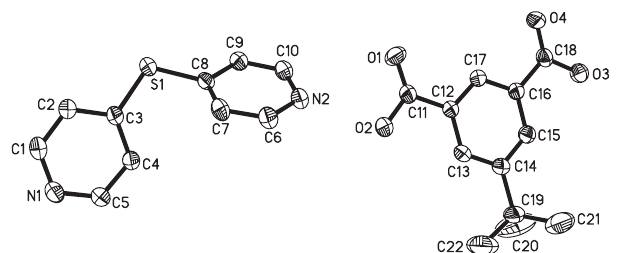
Table 1. Data collection and handling.